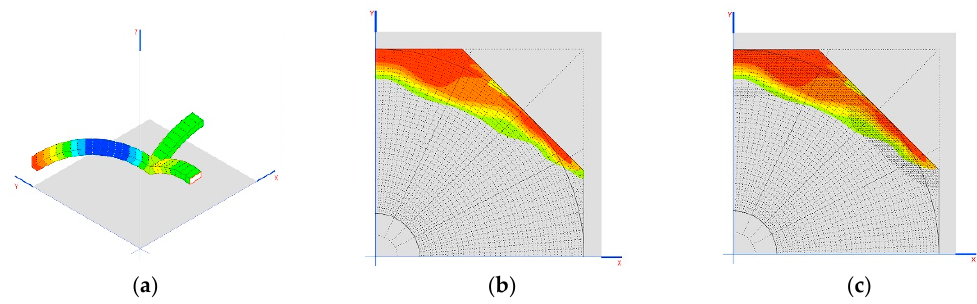
Figure 10. ( a ) Stresses in the arches; ( b ) traction stresses MPa; ( c ) plasticized areas (shaded area).